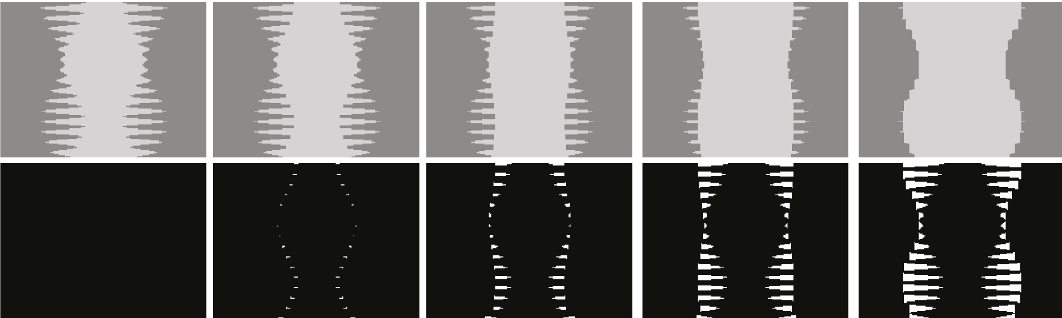
Figure 13: Succession of closings with vertical structuring elements and the corresponding di ff erences (between the original image and the closings).